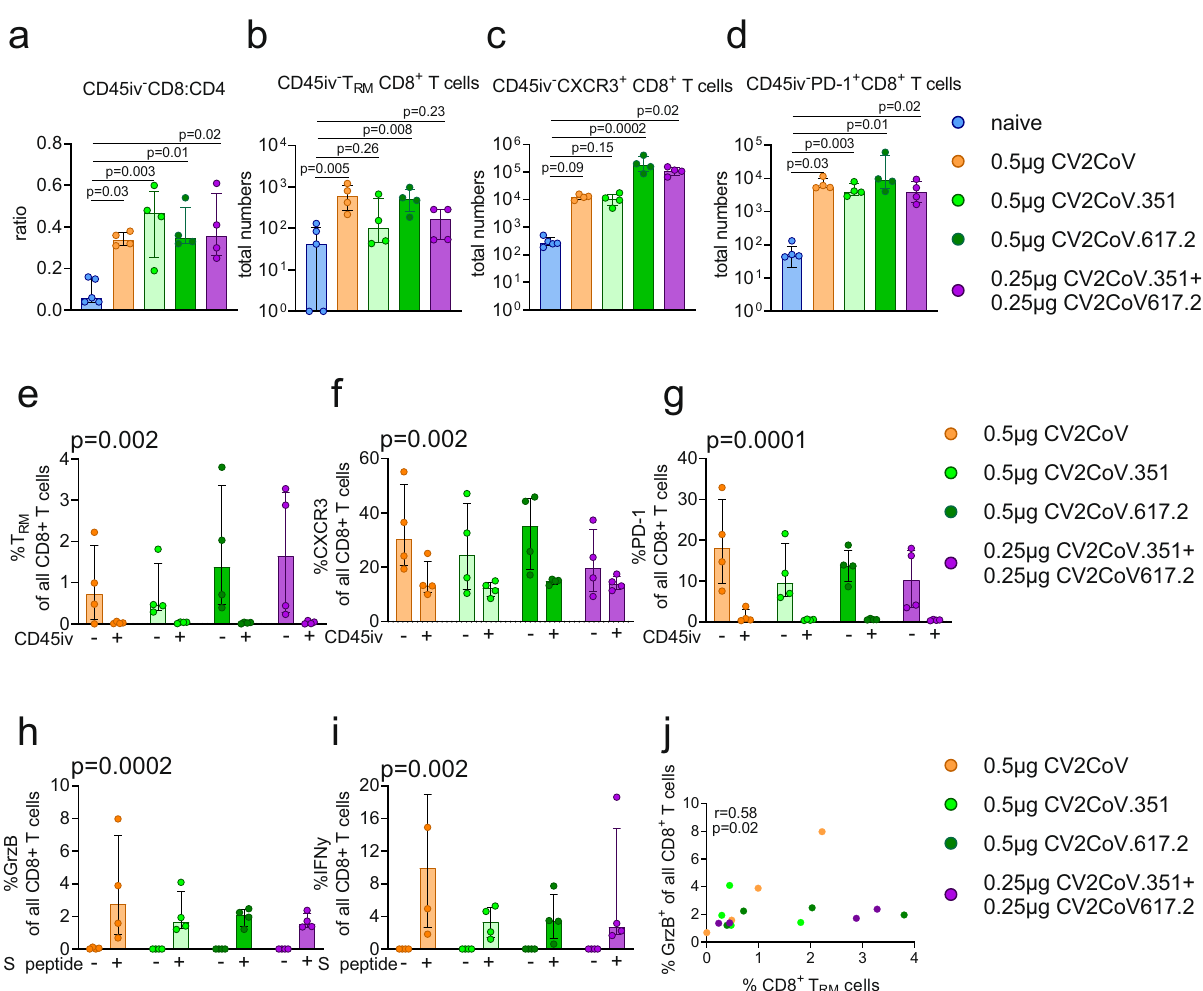
CD8 + Tcells( h )andIFNyproductionbyCD8 + Tcells( i )wasinvestigatedbyinvitro re-stimulation oflung cells with S-peptide poolsderived from ancestral SARS-CoV- 2. j correlation of CD8 + T RM cells and GrzB + CD8 + T cells determined by a non- parametric spearman correlation test. a – i Scatter plots are labelled with median and interquartile range. P- values were determined by one-way ANOVA and Dunn ’ s multiple comparison test against the naïve group ( a – d ), by two-way ANOVA com- paring CD45iv - versus CD45iv + ( e – g ), or by two-way ANOVA comparing no stimu- lation ( − ) against stimulation with S-peptide (+) ( h , i ). Differences were considered signi fi cant at p <0.05 with exact p -values displayed in the fi gure. Source data are provided as a Source Data fi